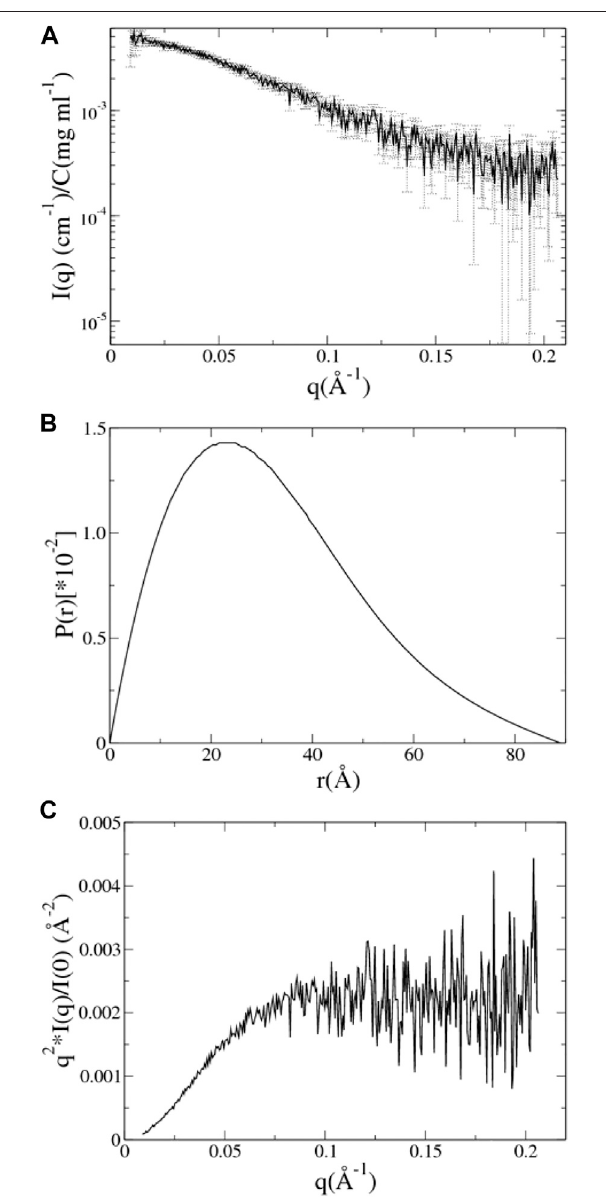
FIGURE 3 | SAXS data analysis of UL11. (A) The experimental SAXS pro fi le ofUL11 is shown with errors. (B) The pair distance distribution function (PDDF) is normalized so that the sum under the curve is 1. (C) Kratky plot.